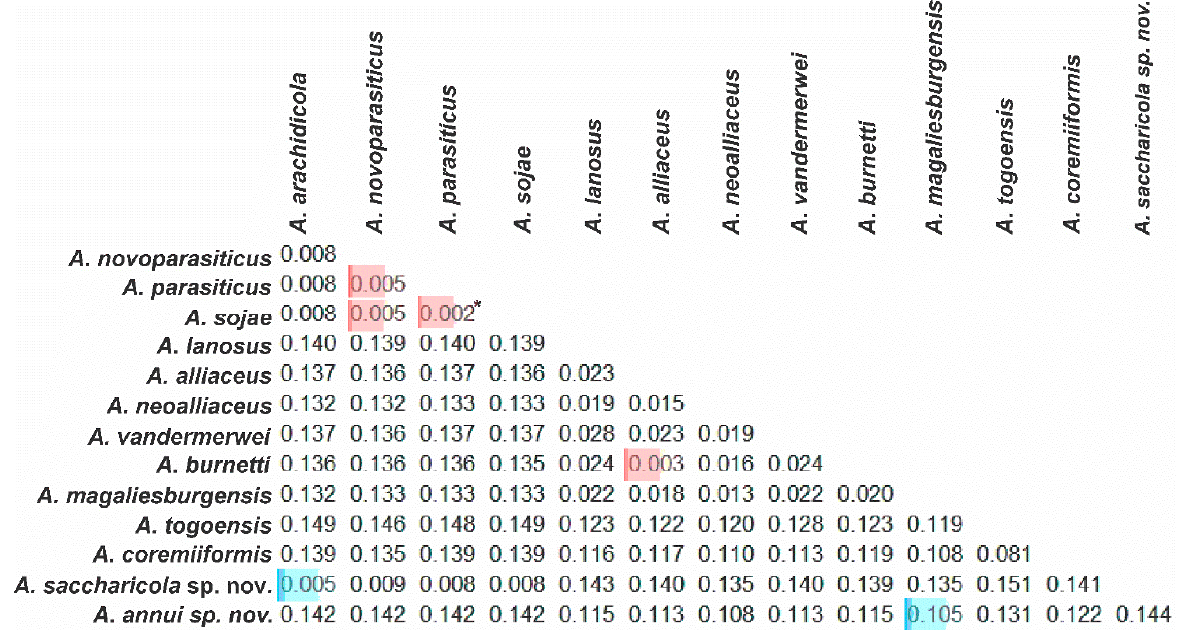
Figure 6. Pairwise genetic distance matrix of the combined dataset ( CaM+BenA+RPB2 sequences), among Aspergillus section Flavi species. Highlights in red = smallest distances found in this dataset. Highlights in blue = smallest distances found between the newly proposed species Aspergillus annui sp. nov. and Aspergillus saccharicola sp. nov. in relation to currently accepted species in Aspergillus section Flavi. * note= A. sojae is a non-toxigenic domesticated variant of A. parasiticus.